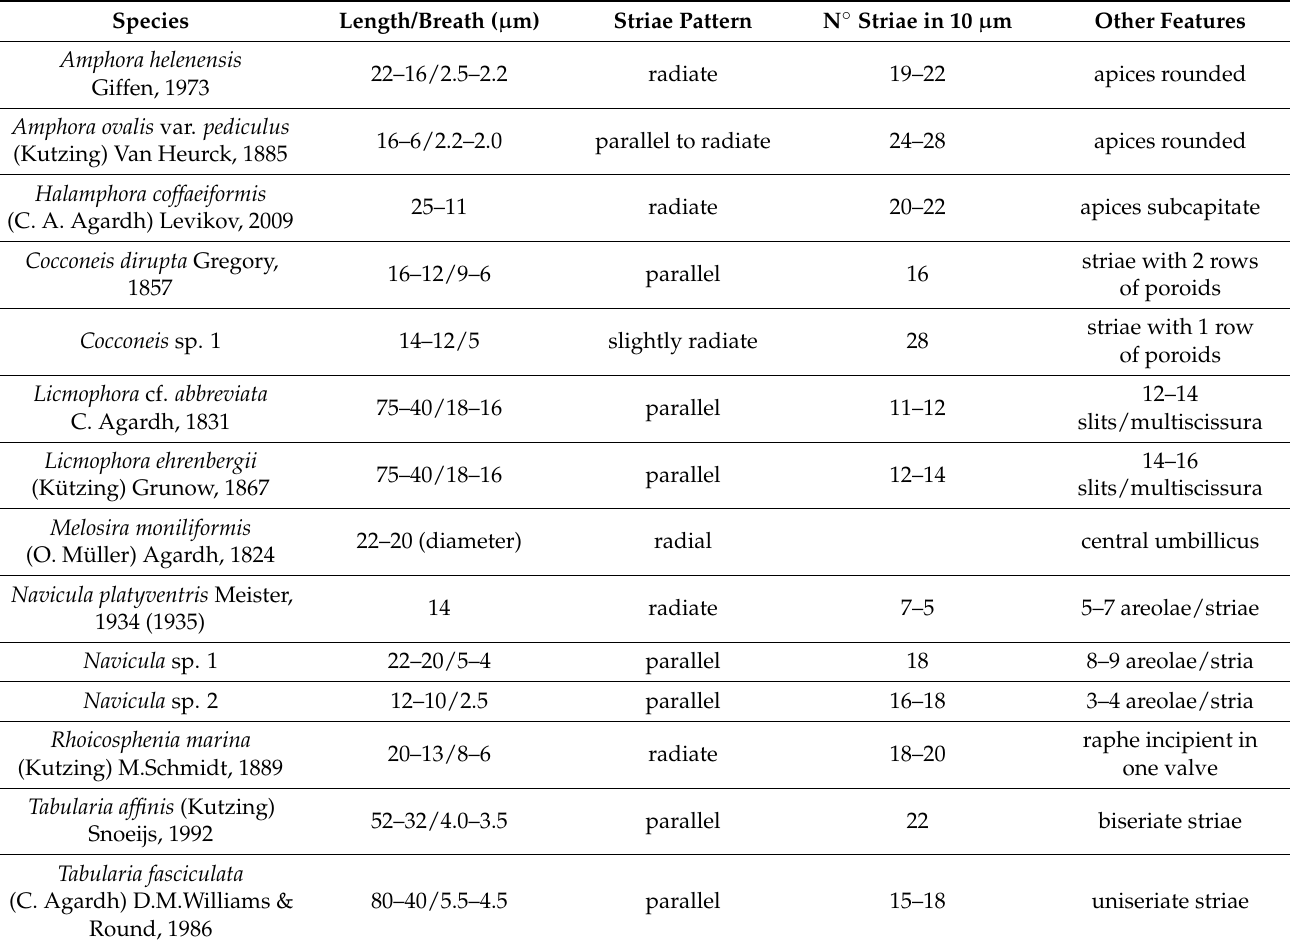
Table 1. Morphometric data of the 14 epibiotic diatom species recorded on the amphipods, sampled in estuaries of South